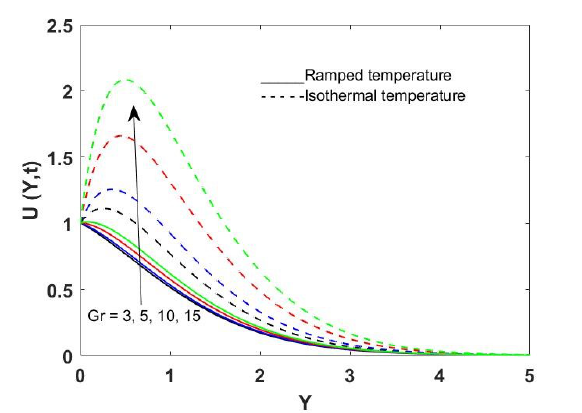
Figure 7: Momentum distribution versus Gr t =0.3, R=0.2, S=1, K=1,